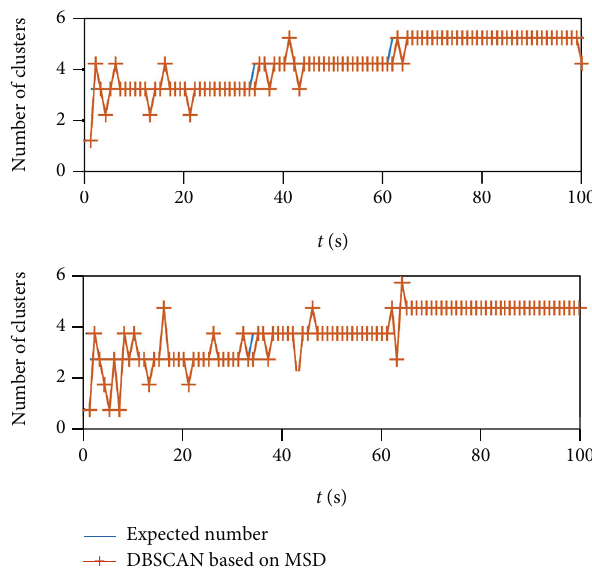
Figure 15: Comparison of cluster identi fi cation results based on the MSD and the PSD.